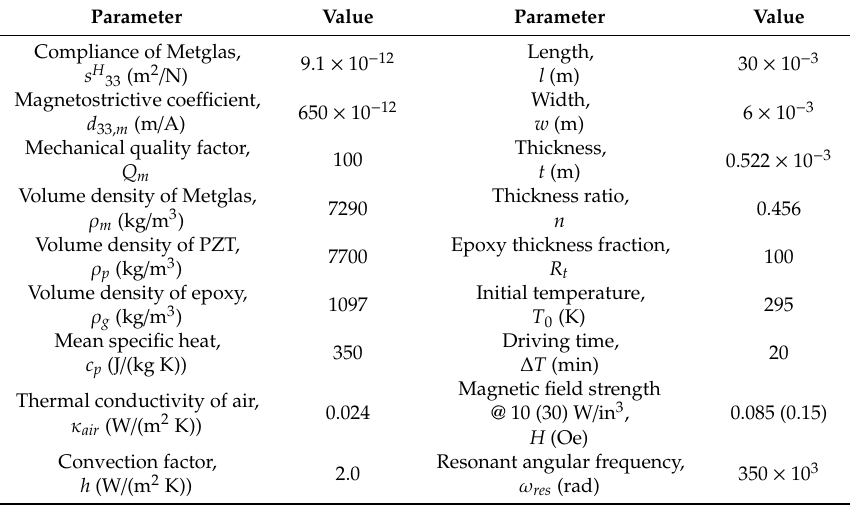
Figure 3. Temperature rising as a function of the driving time with a power density of ( a ) 10 W/in 3 and ( b ) 30 W/in 3 . The dashed lines are simulations with Equation (19) and the black squares are experimental data. Simulations using Equation (17) under low drive and high drive conditions are shown in ( c ) and ( d ), respectively. Table 2. Values of the parameters for the simulations.